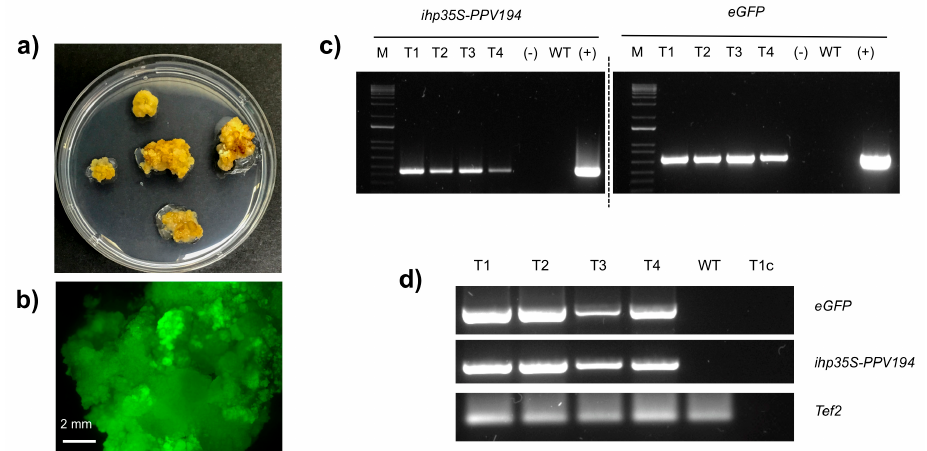
Figure 4. Hansen 536 transgenic callus lines and molecular analysis of transformants: ( a ) Callus line proliferated for five months after Agrobacterium infection. ( b ) Transgenic callus expressing uniform GFP fluorescence. ( c ) Amplification of ihp35S-PPV194 (456 bp) and eGFP (701 bp) genes fragments from the genomic DNAs of four transgenic (T1-T4) and one wild-type (WT) callus lines obtained from different MBs, and pK7WG2-ihp35S-PPV194::eGFP “(+)”. The lane labelled “( − )” shows the PCR result using water as negative control. M, DNA marker (1Kb Plus DNA Ladder, Invitrogen, Carlsbad, CA, USA). ( d ) RT-PCR analysis of eGFP (701 bp), ihp35S-PPV194 (456 bp) sequences of four transgenic (T1-T4) and one wild-type (WT) callus